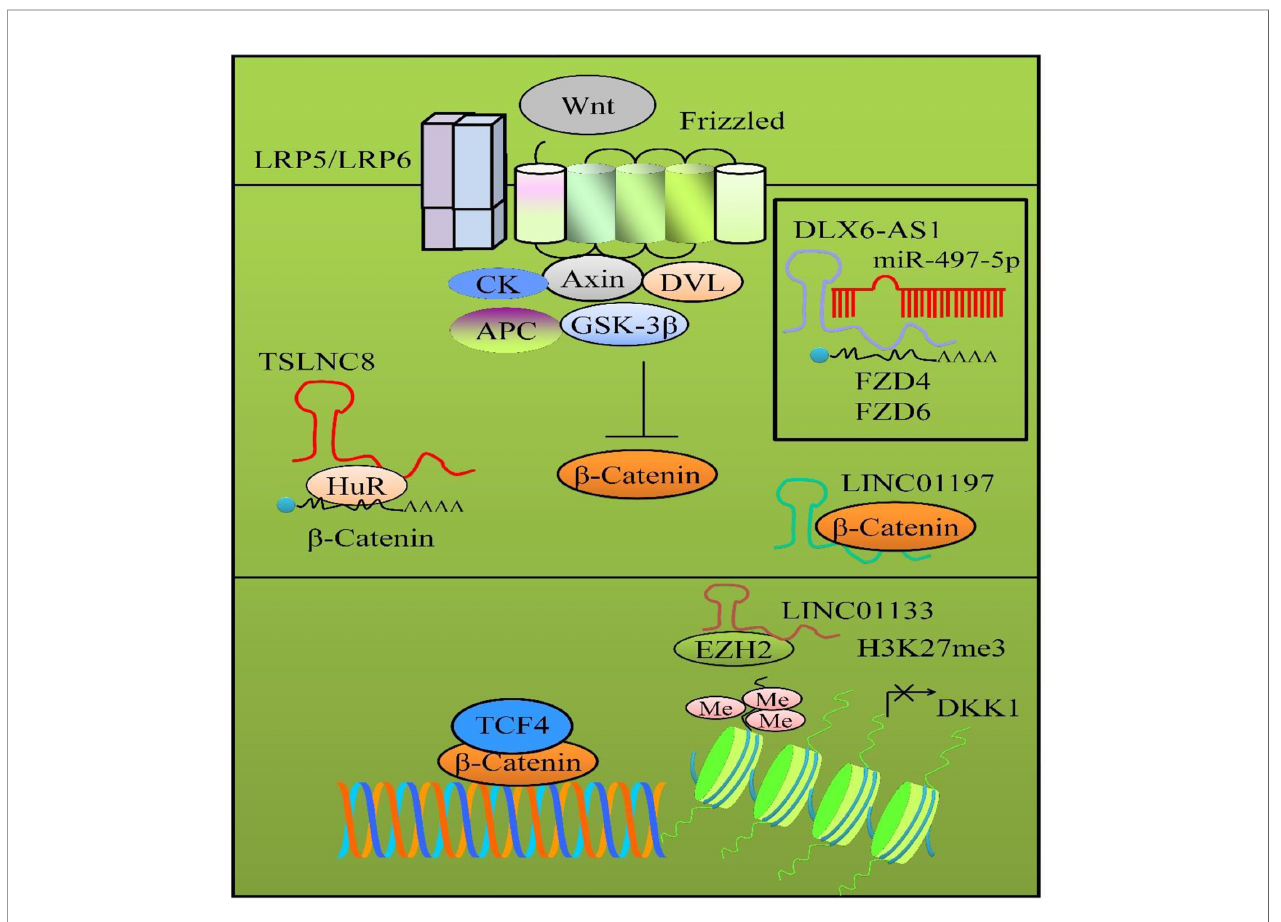
FIGURE 2 | Wnt/ b -catenin signaling in pancreatic cancer. b -catenin moves into the nucleus to transcriptionally modulate wide-ranging target gene networks. LncRNAs regulate different proteins in Wnt/ b -catenin pathway. LINC01197 physically associated with b -catenin and inhibited Wnt/ b -catenin signaling cascade. DLX6-AS1 interfered with miR-497-5p-mediated targeting of FZD4 and FZD6. TSLNC8 promoted the binding of HuR to b -catenin mRNA to stabilize b -catenin. LINC01133 promoted the loading of EZH2 to transcriptionally downregulate